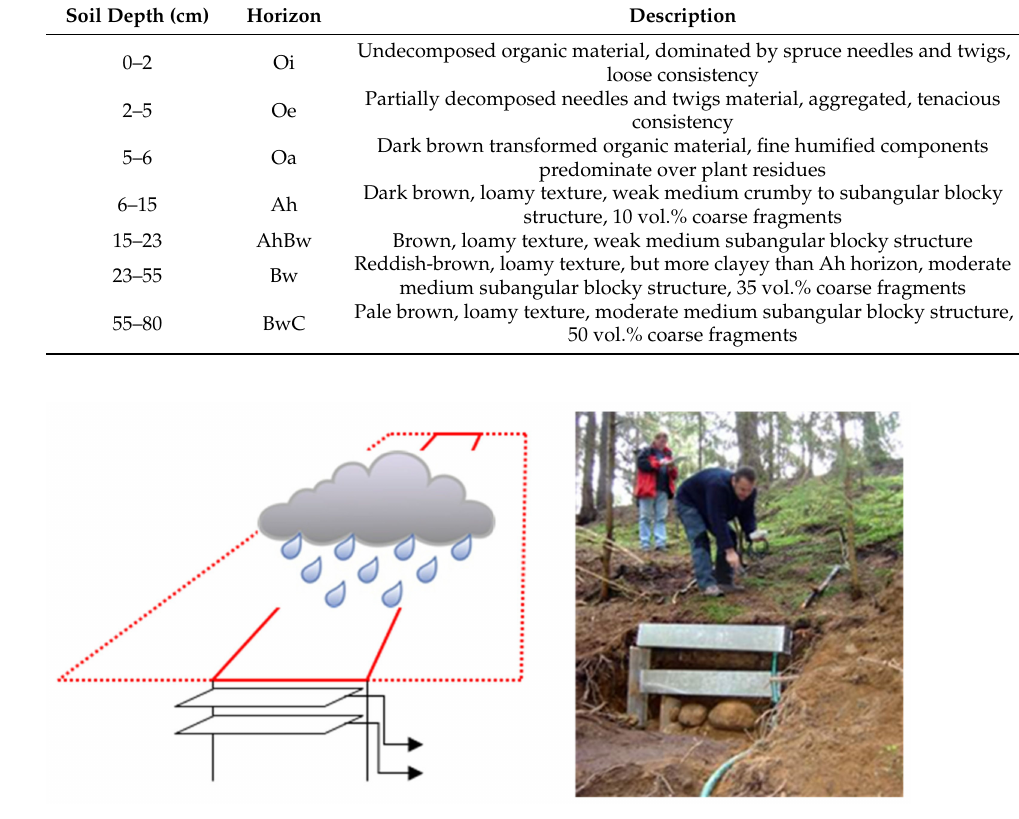
Figure 2. Scheme of the field irrigation experiment with outflow recording. The dotted lines demarcate the total irrigated area (6 m 2 ), while the solid lines delimit the experimental area (2 m 2 ) where the water balance was